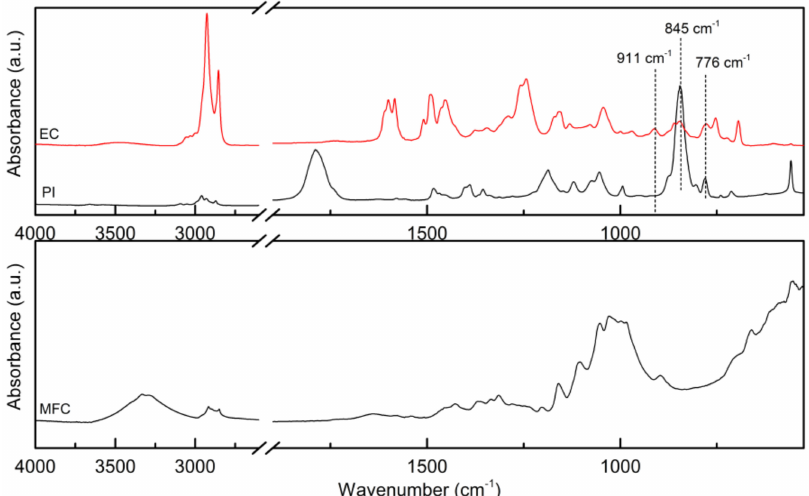
Figure 6. FT-IR transmission spectra of the epoxidized cardanol (EC) and of the photoinitiator (PI), and ATR FT-IR spectrum of the non-impregnated MFC mat (dry